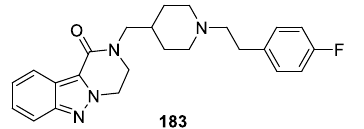
Figure 61. Chemical structure of 3,4-dihydropyrazino[1,2- b ]indazol-1(2 H )-one derivative 183.